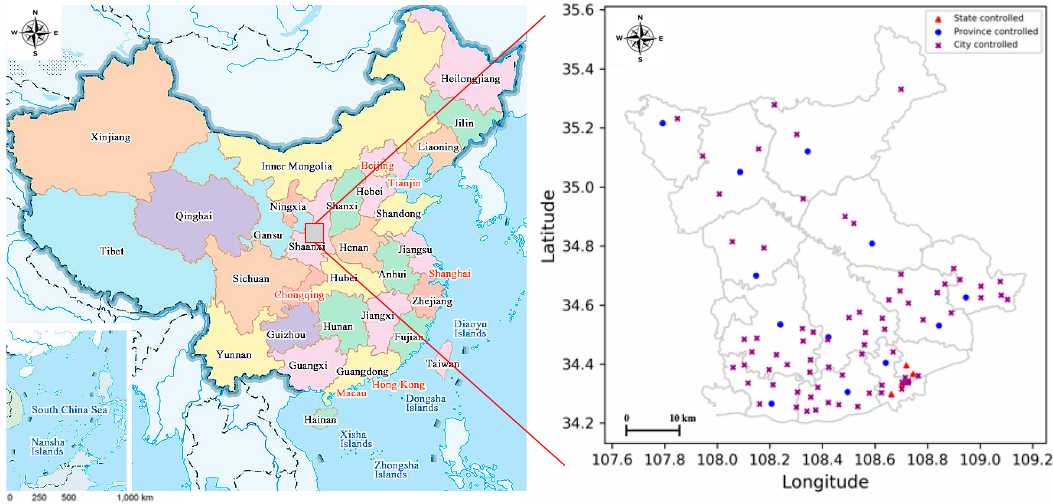
Figure 1. Geographical location of Xianyang and monitoring sites.